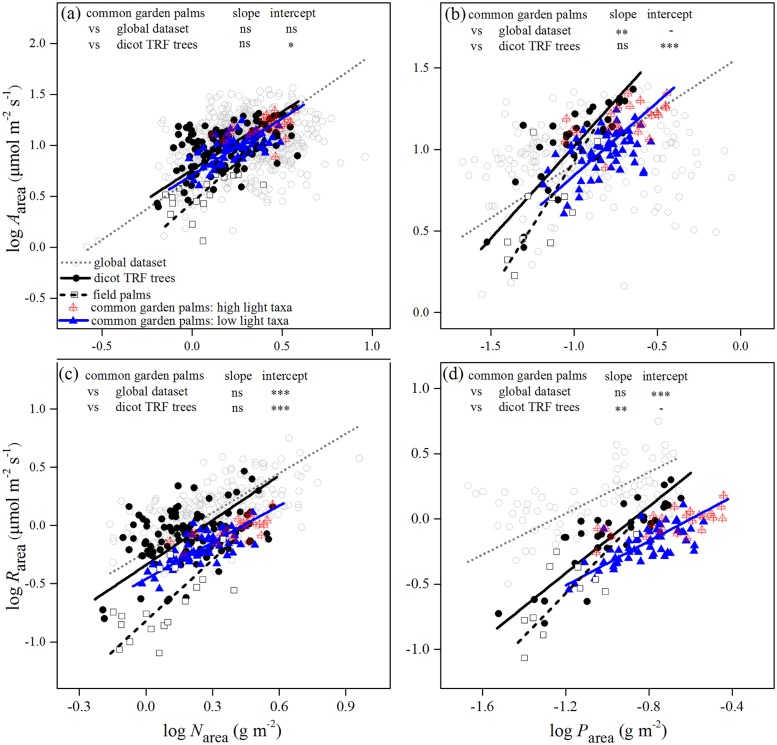
The dependency of photosynthesis and dark respiration on foliar area-based N (N
area) and P (P
area) across common garden palms, field palms, species from a global dataset and dicotyledonous broad-leaved trees in tropical rain forests (dicot TRF trees).(a, b) Area-based maximum photosynthetic rate (A
area), (c,d) area-based dark respiration rate (R
area). Relationships in each dataset are significant and their standardized major axis (SMA) regression lines are shown. The differences in SMA regression slope and intercept between common garden palms and two other non-palm datasets are indicated (see S4 Table for the differences between field palms and two other non-palm datasets). ns, P > 0.05, * P < 0.05, ** P < 0.01, *** P < 0.001.